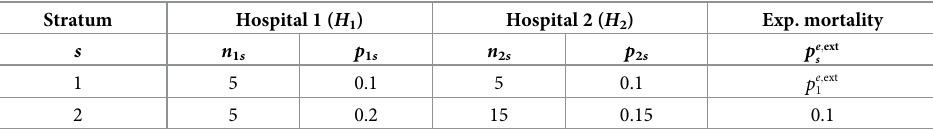
Table 4. Example of variations in expected mortality rate under external standardization: Parameter values.